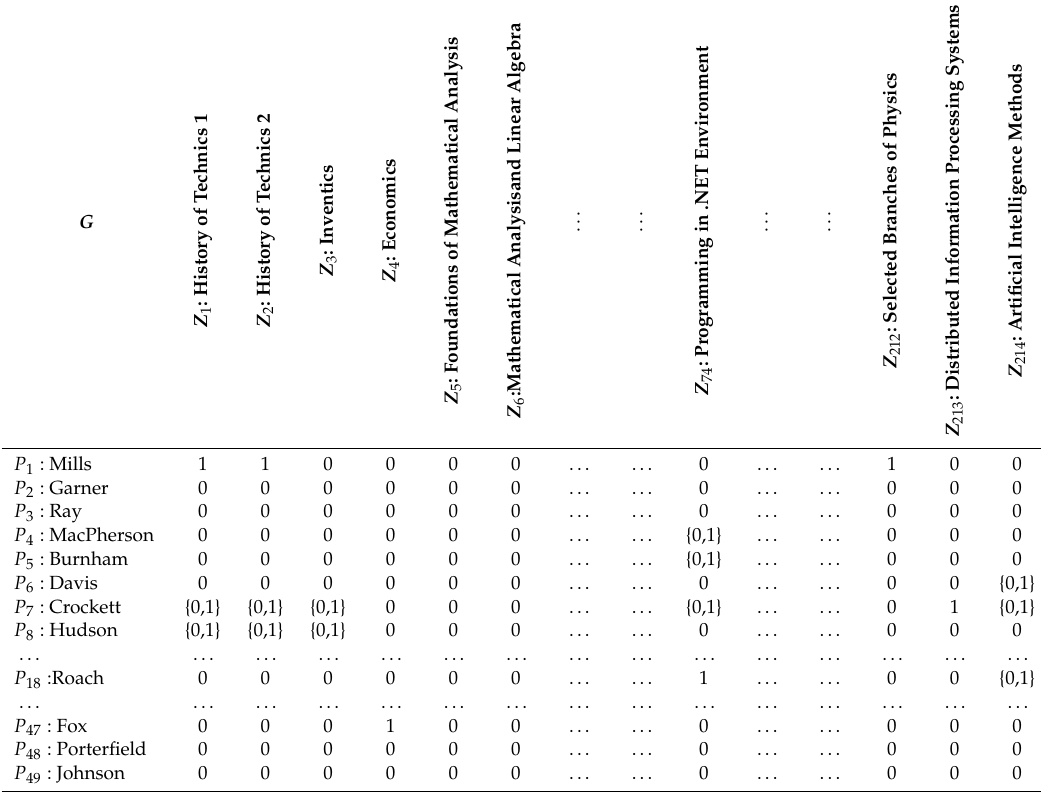
Table 6. Competency framework, G , of FECS teaching sta ff (source: https: // github.com / erykszw / TAP).